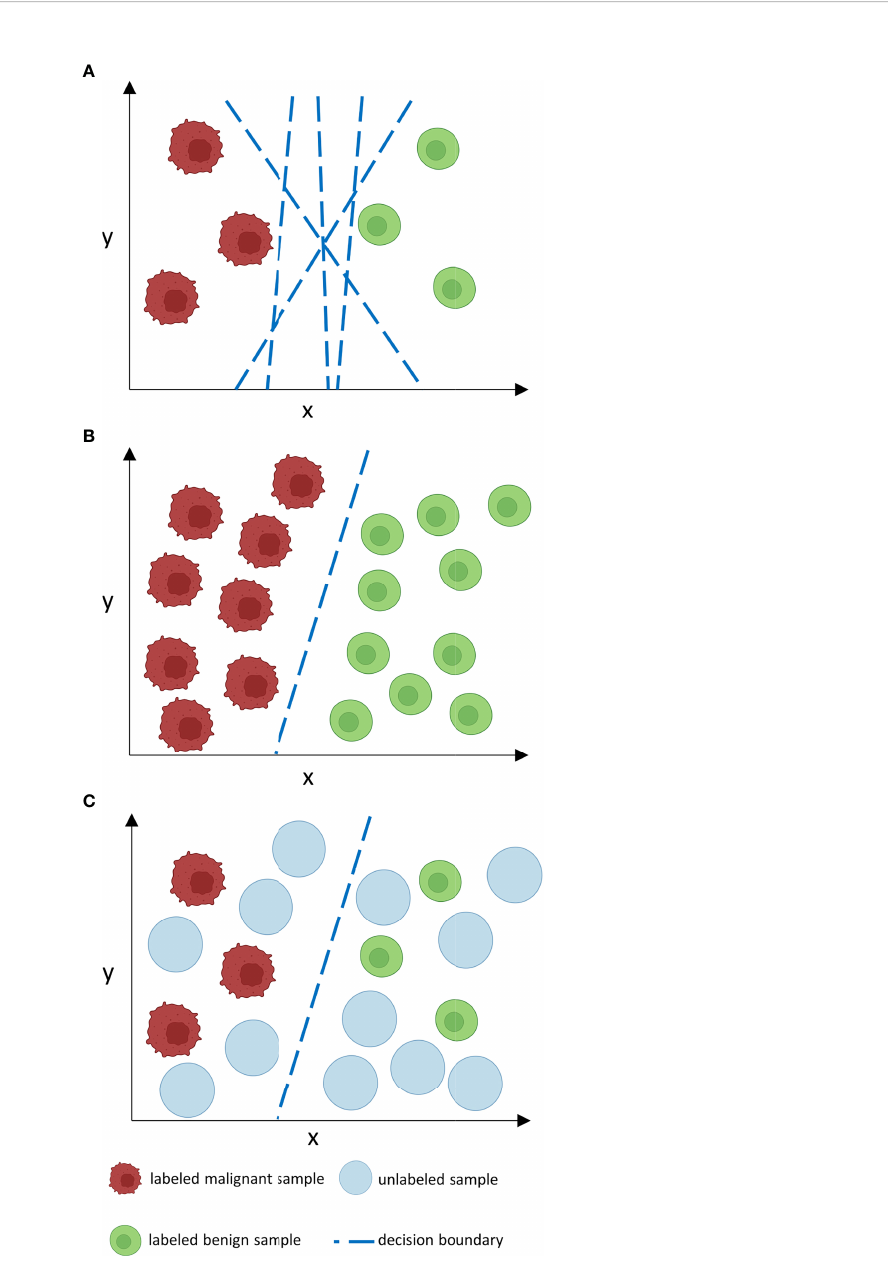
FIGURE 2 How does unlabeled data boost classi fi cation performance? Consider a number of features n at the input level which corresponds to an n - dimensional feature space. In such an n-dimensional coordinate system, every input is located according to its feature vector given by its n features and can thus be sorted by similarities and differences in relation to other inputs which is represented by proximity or distance points in the feature space. For clarity reasons, we only consider two features (x, y) in a two-dimensional feature space. When labeled data is sparse (A) , as is often the case in medical data sets, the decision boundary of a classi fi er is less constraint. This may lead to inaccuracies and poor generalization on external data. If many labels are given, the decision boundary is more constraint and thus a more accurate classi fi er is given that can potentially generalize better. However, manual labeling of such large data sets is often time- and cost-ineffective. Unlabeled data is often available in abundance (C) and can be used to constrain the decision boundary of a classi fi er in a way as large labeled data sets could do, however, without the need for excessive labeling. The decision boundary then lies in an area with low density. Nevertheless, as can be derived from (B) and (C) , the performance gap between supervised and semi-supervised learning shrinks as the amount of labeled data grows if no further unlabeled samples are